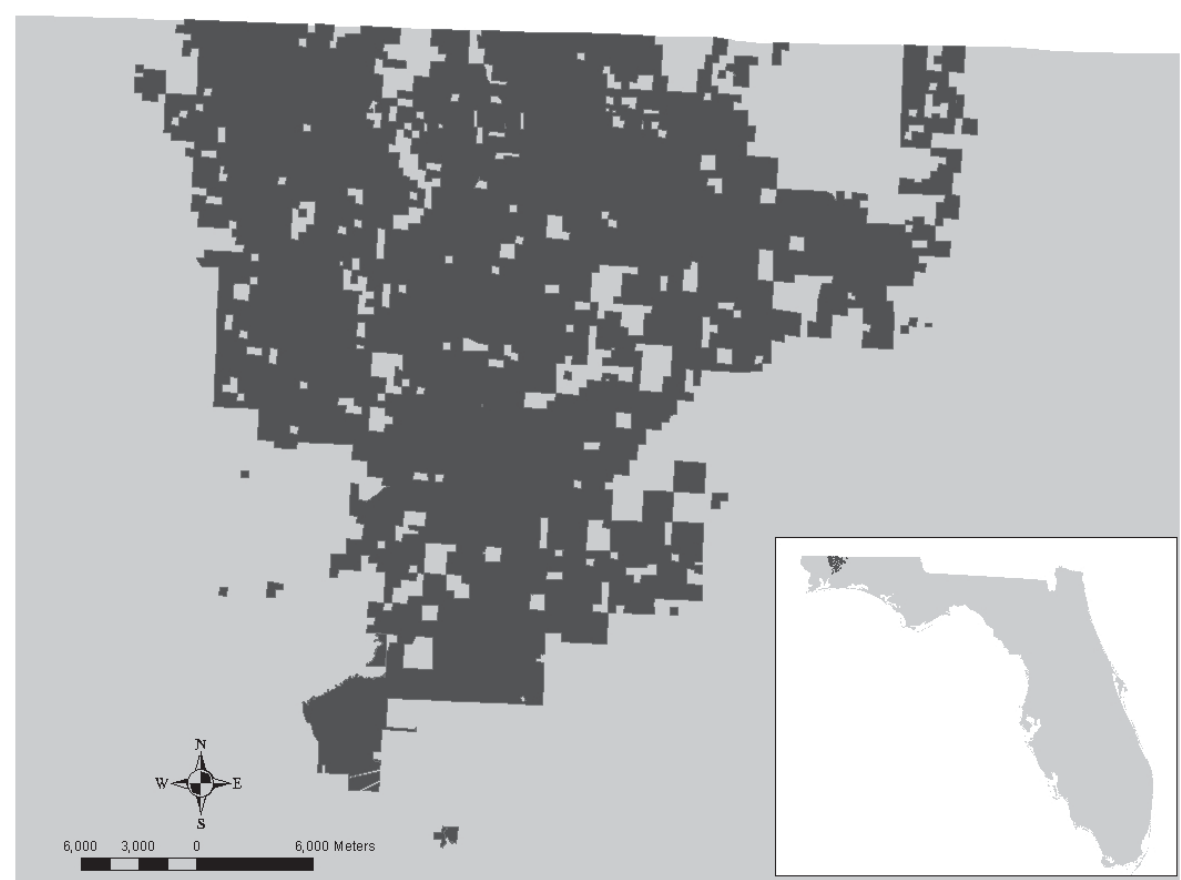
Figure 1. Map depicting Blackwater River State Forest and location within the Florida